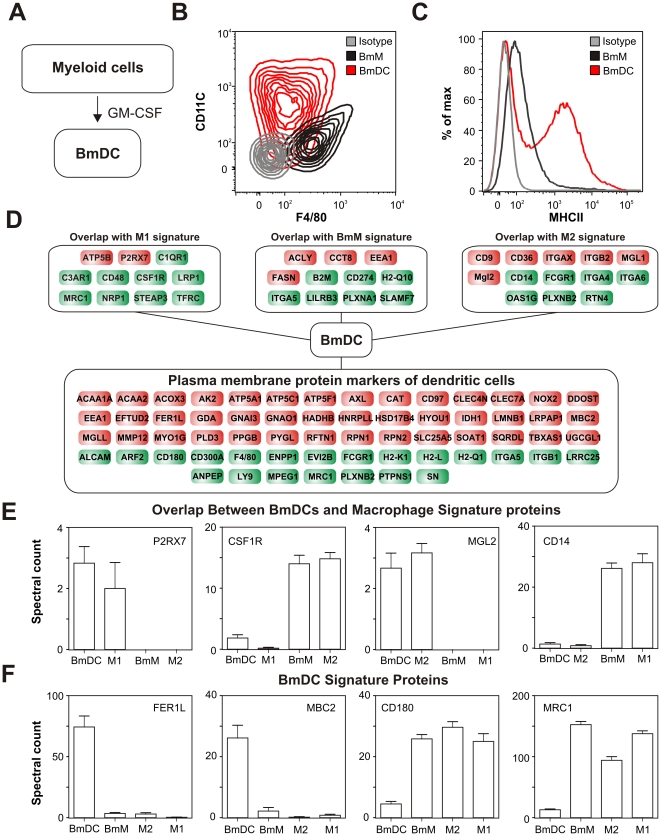
The plasma membrane proteome of bone marrow-derived dendritic cells (DCs).
Panel A: Bone marrow-derived dendritic cells (BmDCs) were obtained by culturing bone marrow cells with GM-CSF. Panel B: Flow cytometric analysis of CD11c and F4/80 expression in BmDCs and BmMs. Results are presented as a contour plot with 10% probability increments. Panel C: Cell-surface exp ression of MHC-II by BmDCs and BmMs as assessed by flow cytometry. Panel D: The plasma membrane proteome of DCs. Upper Panel: Proteins expressed at similar levels by DCs and either M1 cells, M2 cells, or BmMs. Lower Panel: Proteins differentially expressed by DCs relative to M1 cells, M2 cells, and BmMs (G-test>1.5 or <−1.5 and t-test: p<0.05). Red, upregulated; green, downregulated. Panel E: Examples of proteins expressed at similar levels by DCs and either M1 cells, or M2 cells. Results (N = 6 per group) are means and SDs. Panel F: Examples of plasma membrane proteins differentially expressed by DCs. Flow cytometry experiments are representative of 3 independent analyses.